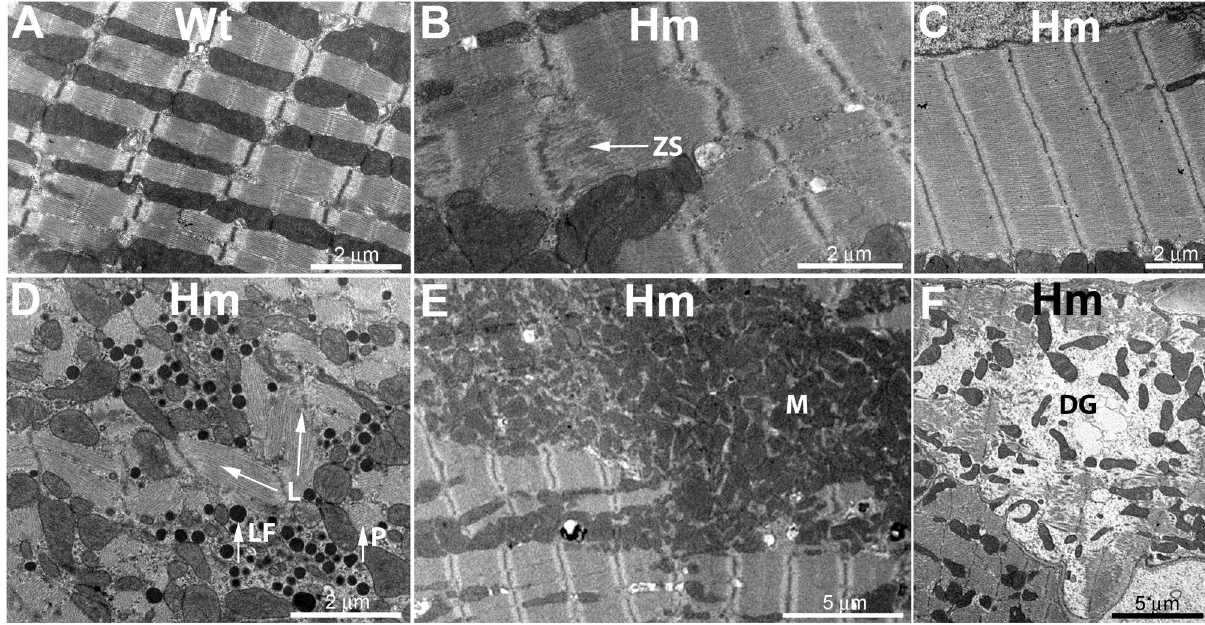
Figure 3. Electron microscopy of wild type and homozygous mutant left ventricle from rats one year of age. Samples were fixed, embedded, sectioned, and stained using standard methods prior to electron microscopic examination (see Materials and Methods for full details). A. Typical wild type cardiomyocyte appearance with myofibrils flanked by mitochondria. B. Homozygote with evidence of Z line streaming (arrow, ZS). C. Homozygote with exceptionally wide myofibril region. D. Homozygote with dark stained lipofuscin granules (arrow, LF). Filament bundles were observed with different orientations in the XY plane (arrows, L) and also running perpendicularly (arrow, P) E. Homozygote with a large cluster of mitochondria (M). F. Homozygote cardiomyocyte region showing myofibril disintegration (DG).